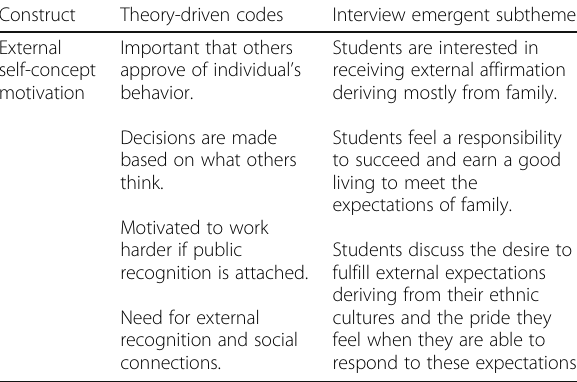
Table 3 Emergent themes related to external